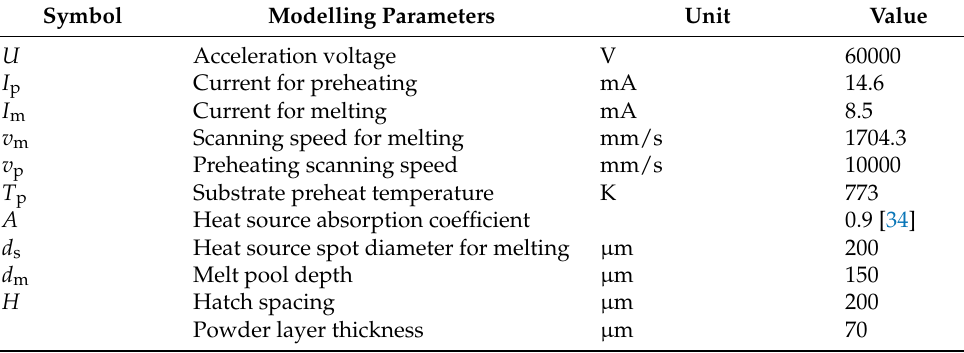
Table 2. EBM process